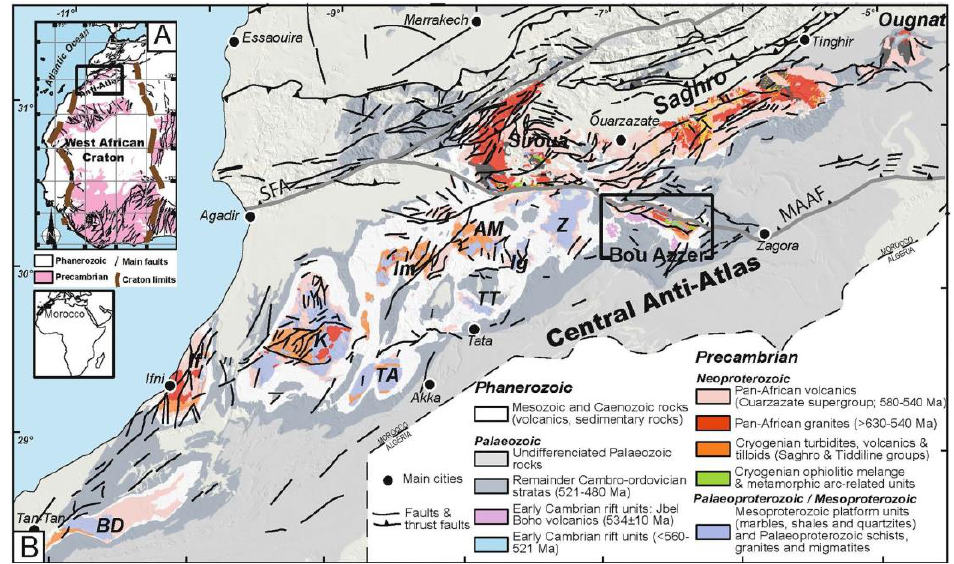
Figure 1. Localization of the studied area at (A) the West African Craton scale and (B) at the Moroccan Anti-Atlas scale [21].